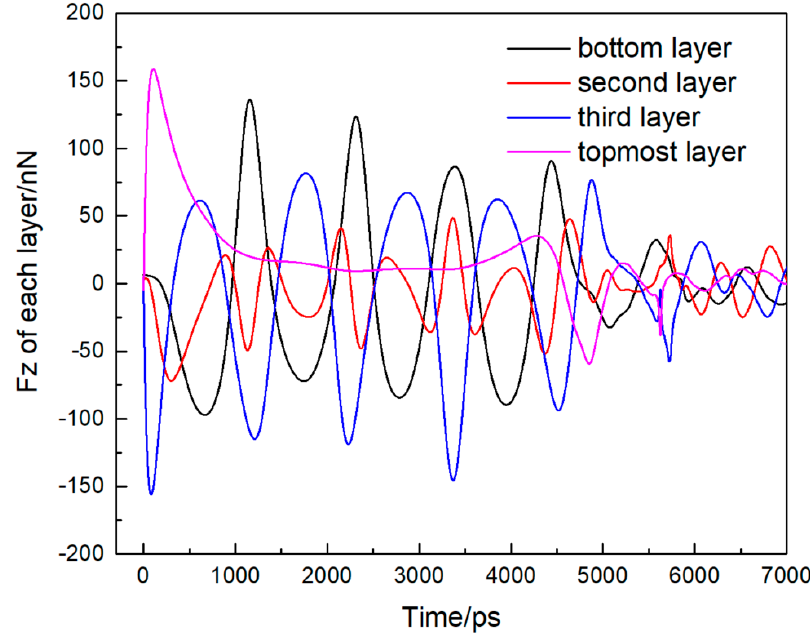
Figure 7. Fz to exfoliate each layer varying with time in four-layer graphene system, when the vertical upward velocity was 10